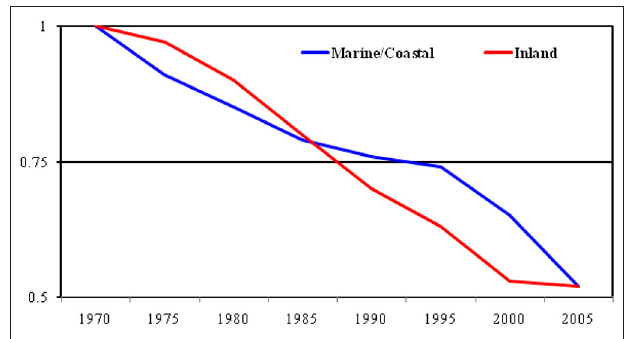
FIGURE 1 | Global Wetland Extent Index (Source: Leadley et al.,